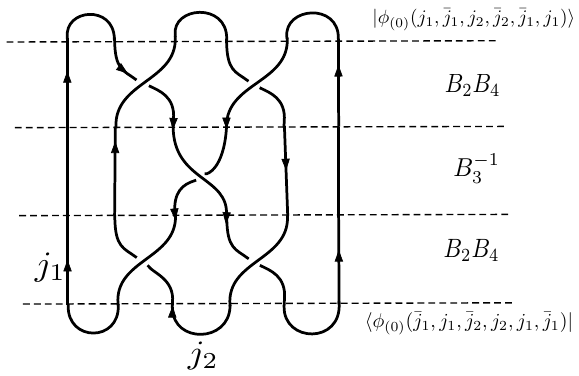
Figure 18 . A plait representation of the Whitehead link 5 2